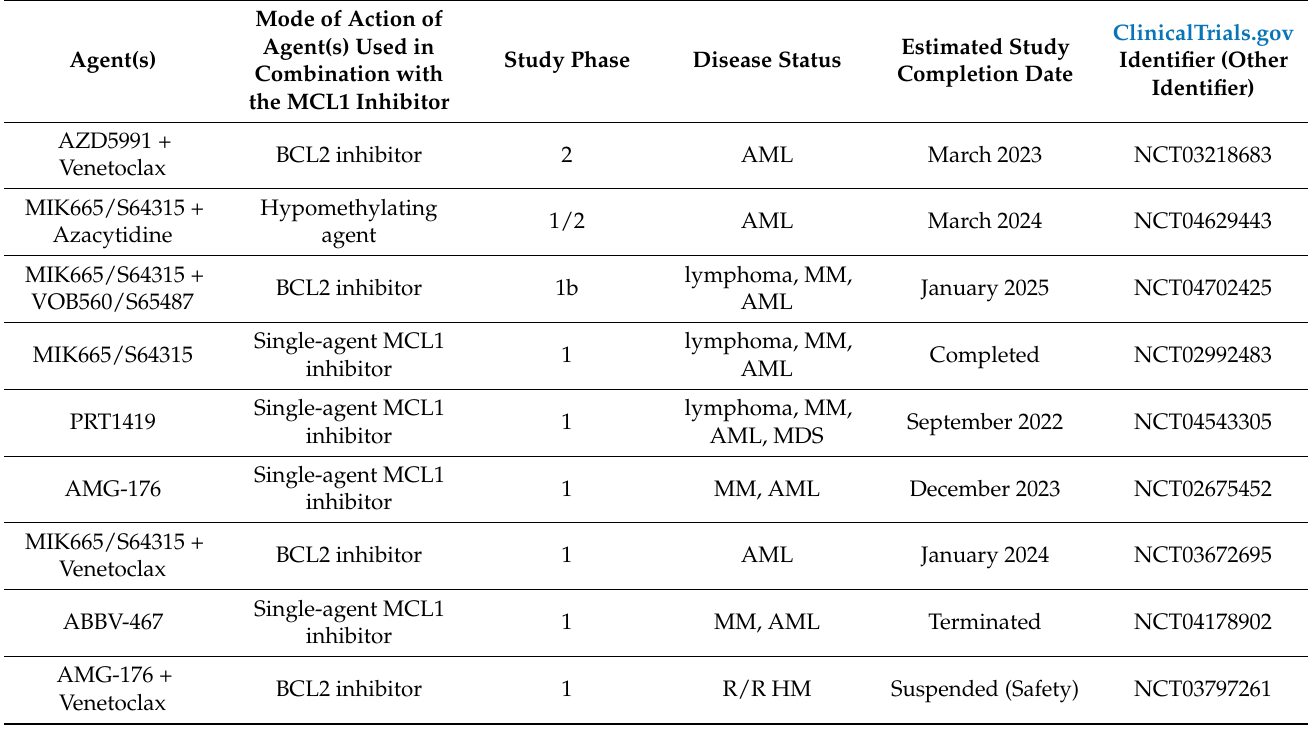
Table 6. Selected clinical trials that incorporate MCL1 inhibitors in experimental therapy of hematologic